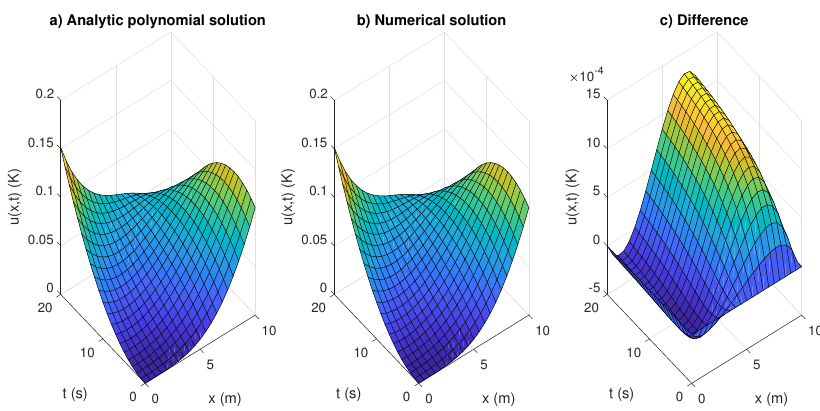
Figure 5. Validation of the scalar field of Equation (22). ( a ) Analytical solution, ( b ) numerical solution, and ( c ) difference between both solutions. Note that the amplitude of the difference is negligible.